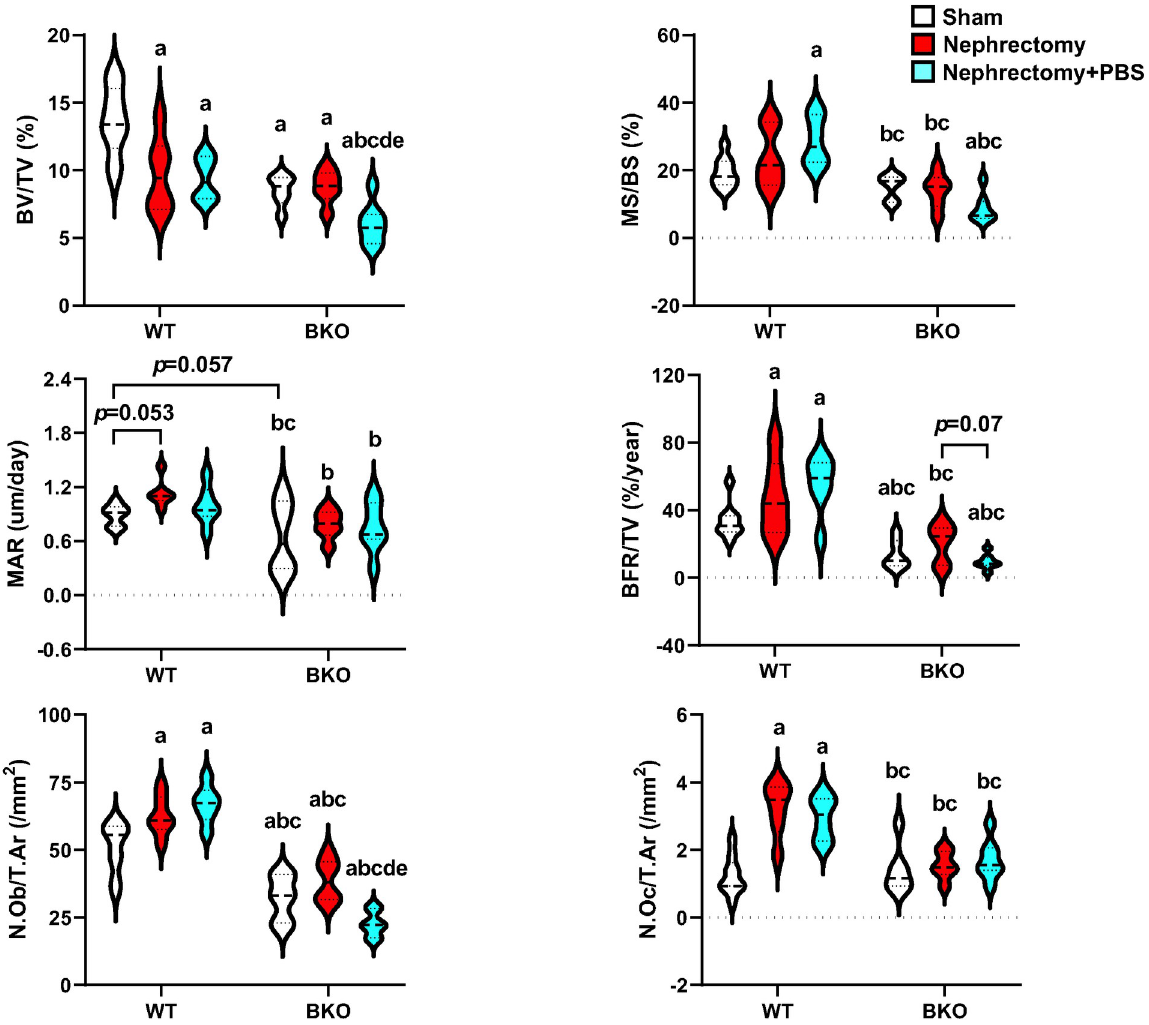
Fig 5. Bone histomorphometric analysis of femurs in BKO mice and WT controls after nephrectomy and PBS exposure. a p < 0.05 versus sham WT, b p < 0.05 versus nephrectomized WT, c p < 0.05 versus nephrectomized WT+PBS, d p < 0.05 versus sham BKO, and e p < 0.05 versus nephrectomized